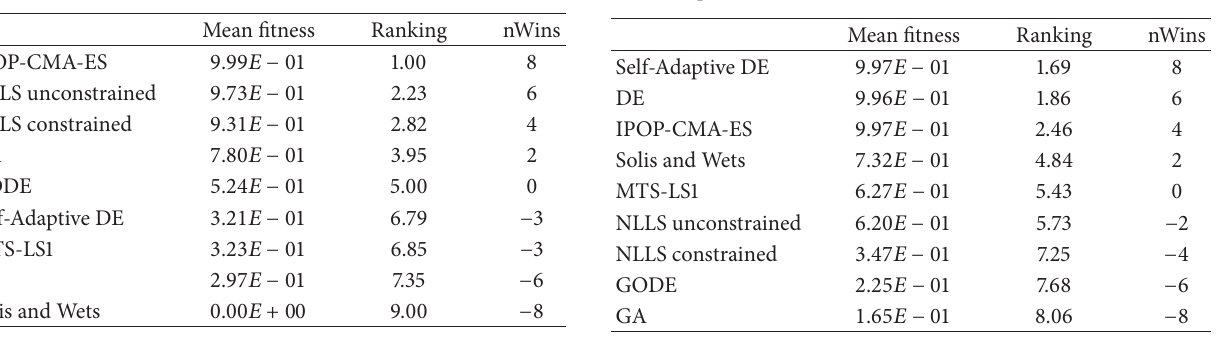
Table 11: Mean fitness, average ranking, and number of wins (nWins) in pair-wise comparisons with the other algorithms on the 8-term Gauss series.